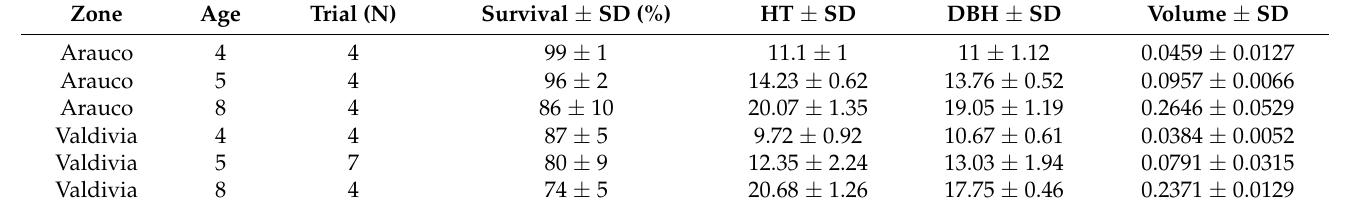
The mean volume per tree and survival of the hybrid was compared with the pure species controls established in each site, measured at 8 years within zones. In this comparison, depicted in Figure 3A, the hybrid survival was lower in both zones compared with the parental species, but that difference was statistically significant only with NIT in Valdivia ( p < 0.05). In general, overall survival was higher in Arauco than Valdivia, and among varieties, NIT had the highest survival in both zones, followed by GLO and finally the hybrid.